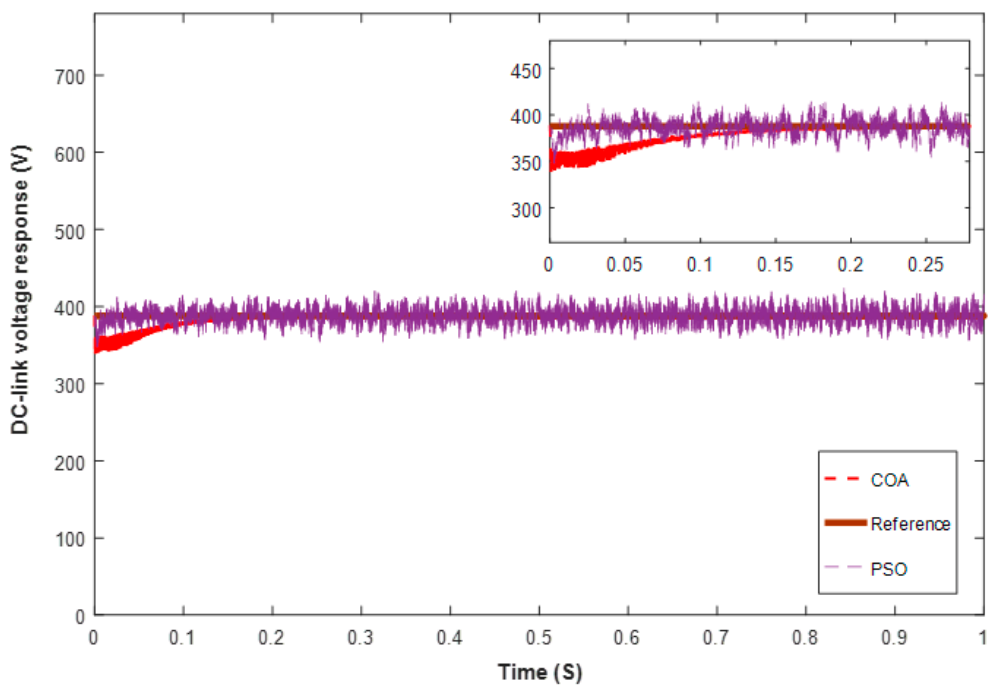
Figure 8. DC-link voltage responses using particle-swarm optimization (PSO) and COA. Table 3. Statistical comparison between PSO and COA.